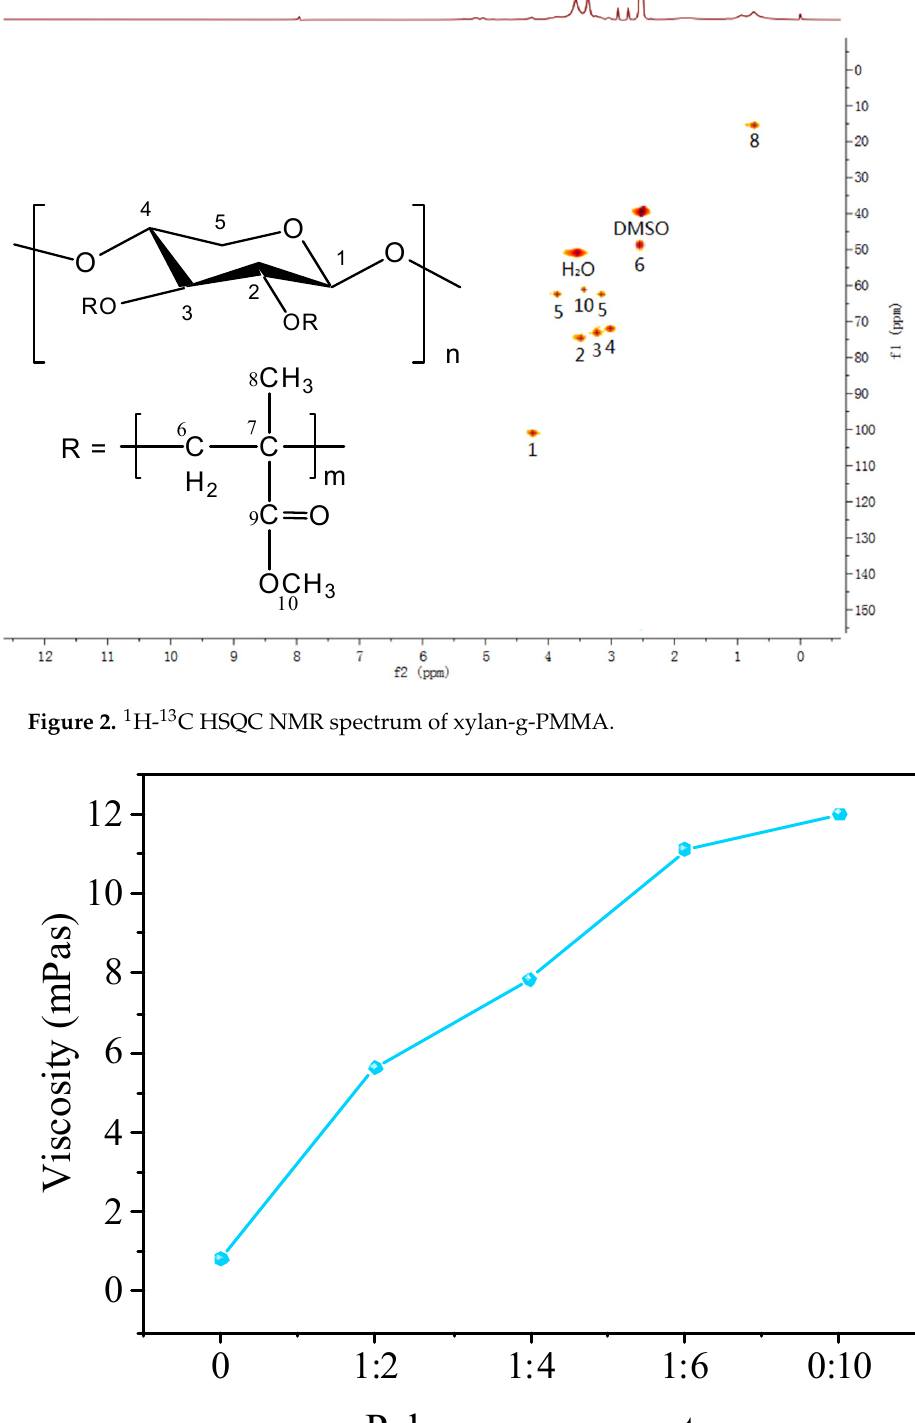
Figure 2. 1 H- 13 C HSQC NMR spectrum of xylan-g-PMMA.